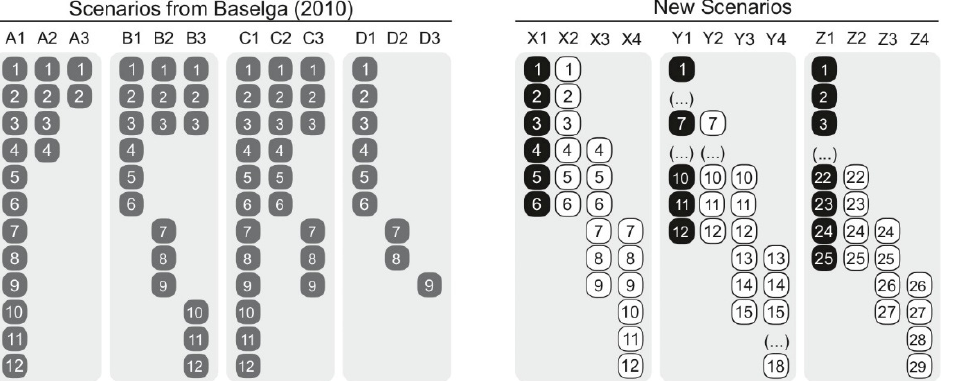
Figure 1. Hypothetical scenarios used in this study: Baselga’s Scenarios (left), retrieved from Baselga [14], that aim to account for nestedness (sites A), spatial turnover (sites B), turnover and nestedness (sites C), and turnover and differences in species richness (sites D); new scenarios (right), with a set of hypothetical assemblages differing in species richness contrasting a reference hypothetical assemblage (black) with assemblages sharing all species, sharing half of the species, and sharing no species (white).